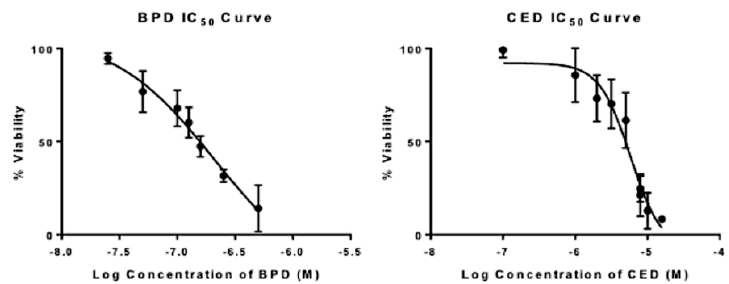
Figure 7. Effect of BPD and CED on U87 cellular survival as shown by IC 50 results of free drugs BPD (left) and CED (right). GraphPad Prism log (inhibitor) vs response-variable slope (four parameters) non-linear regression analysis was used for n = 3 trials. The equation of the line is given as Y = Bottom + (Top-Bottom)/(1 + 10^ ((LogIC50 − X)*HillSlope)) based on GraphPad Prism analysis. Top and bottom refer to plateaus 100 and 0, respectively, on the y-scale for % Viability.